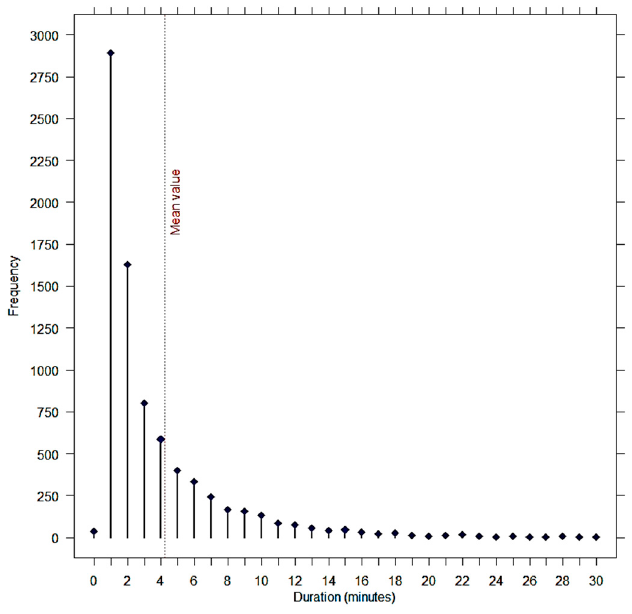
Figure 6. Distribution of the operations durations.